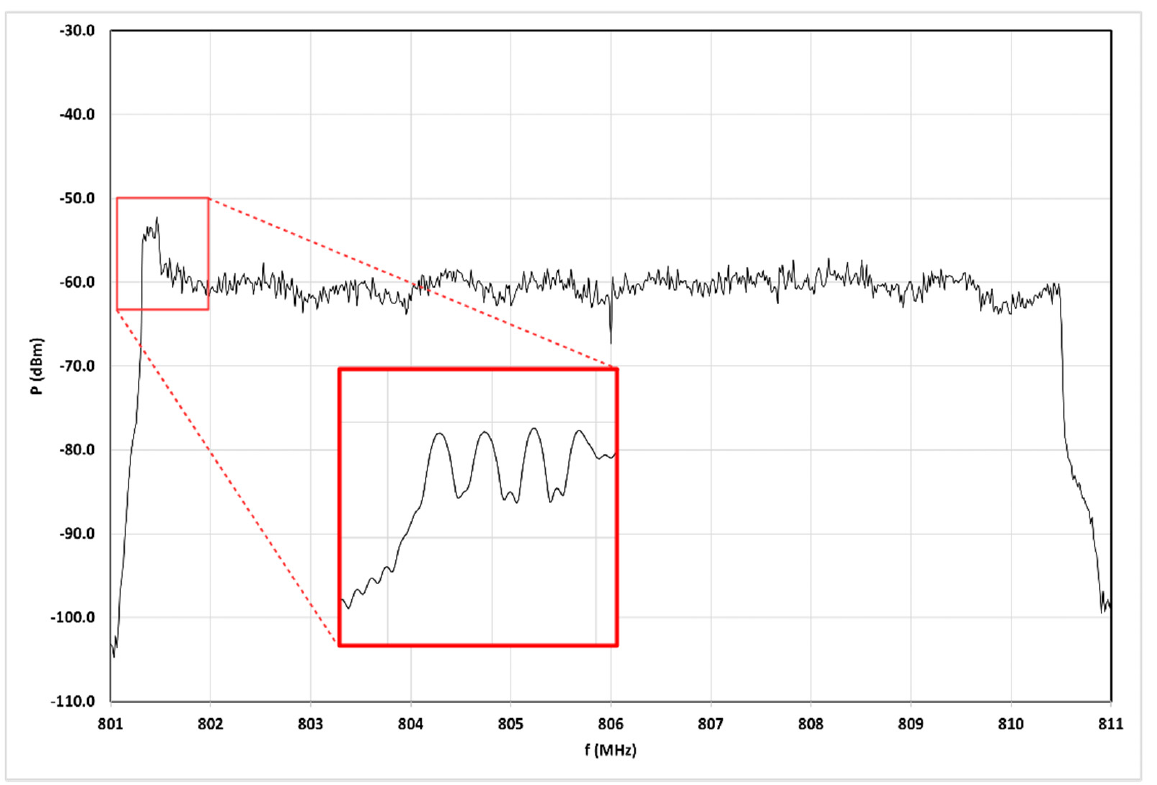
Figure 6. LTE800 signal with guard-band NB − IoT and detail of subcarriers transmitting the NRS.